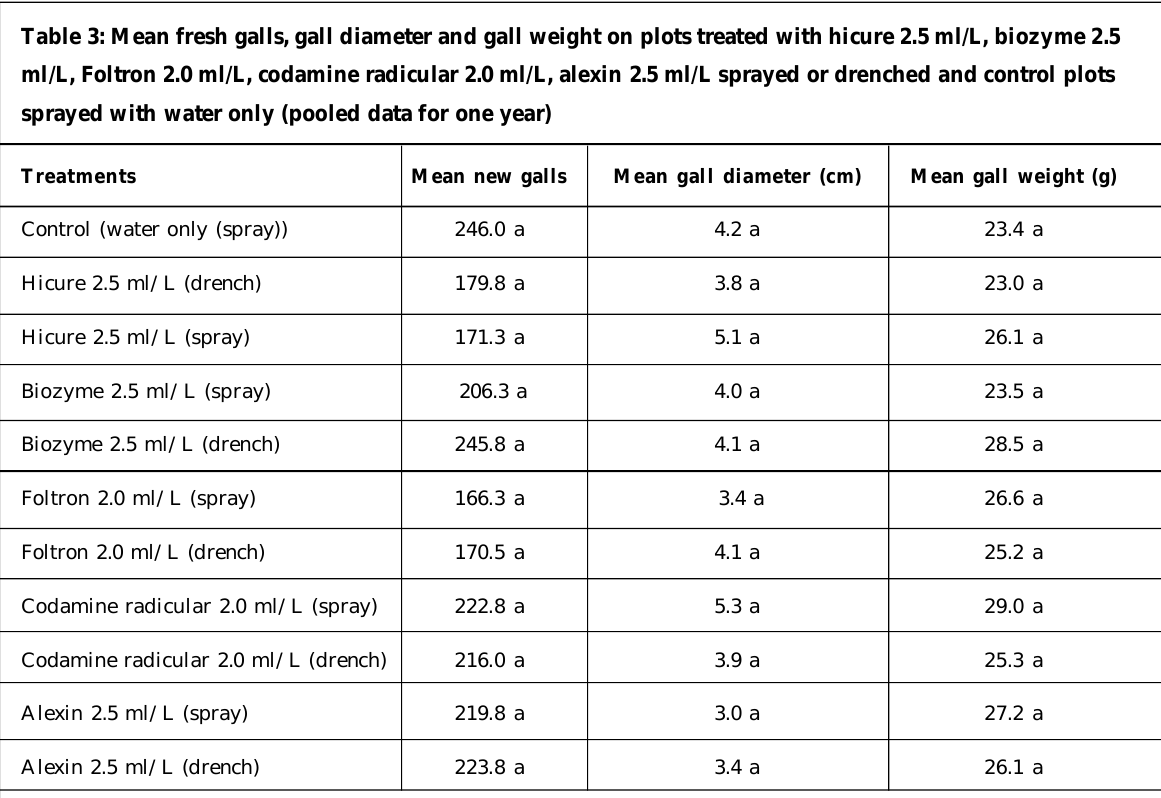
Table 3: Mean fresh galls, gall diameter and gall weight on plots treated with hicure 2.5 ml/L, biozyme